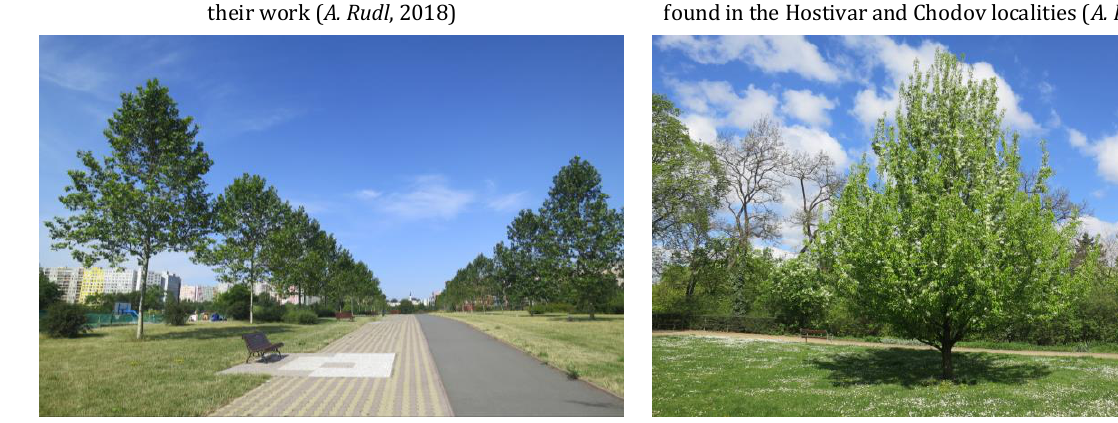
Fig. 3. A plane tree avenue in Stodulky suburb is also a reminder Fig. 4. A Millennium pear tree was planted on the 19th of October 2000 in the Vysehrad quarter of Prague in honour of the re-establishment of the traditional celebration of Tree Day. This pear tree was also planted as a symbolic millennium tree ( A. Rudl , 2018)